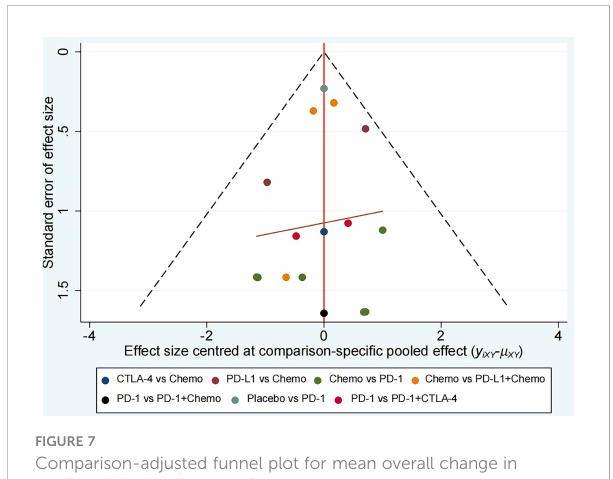
FIGURE 7 Comparison-adjusted funnel plot for mean overall change in cardiotoxicity in all